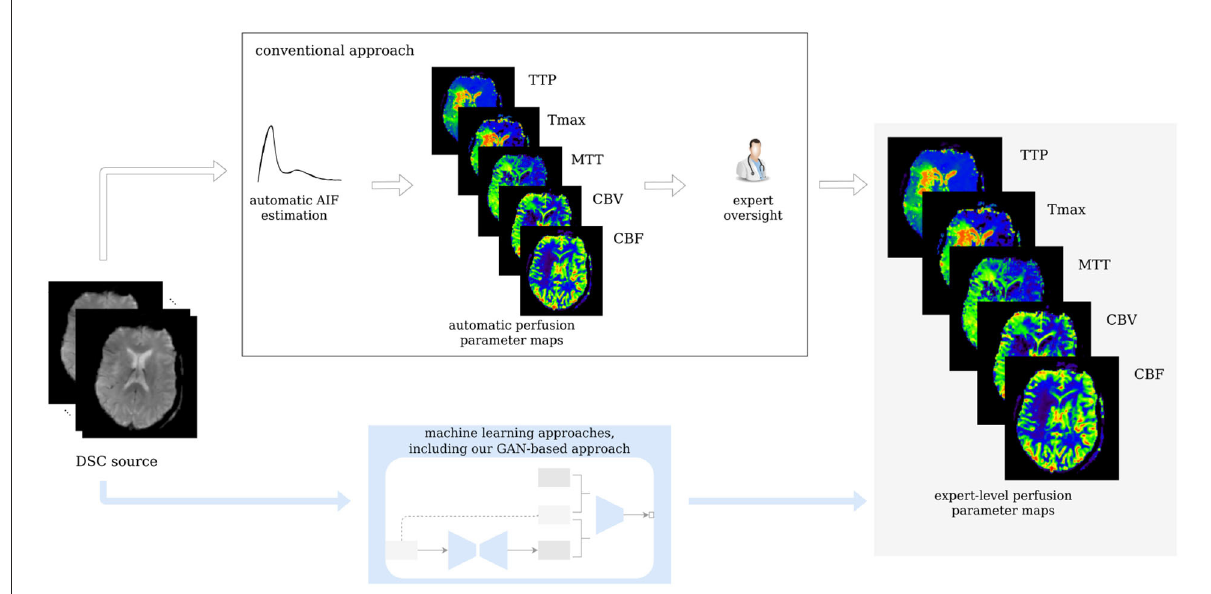
FIGURE1 Workflow of the study. Our GAN is trained on expert-level perfusion maps. The resulting model is able to synthesize perfusion maps from unseen data without the need of manual AIF selection, at the same expert level that was present in the training